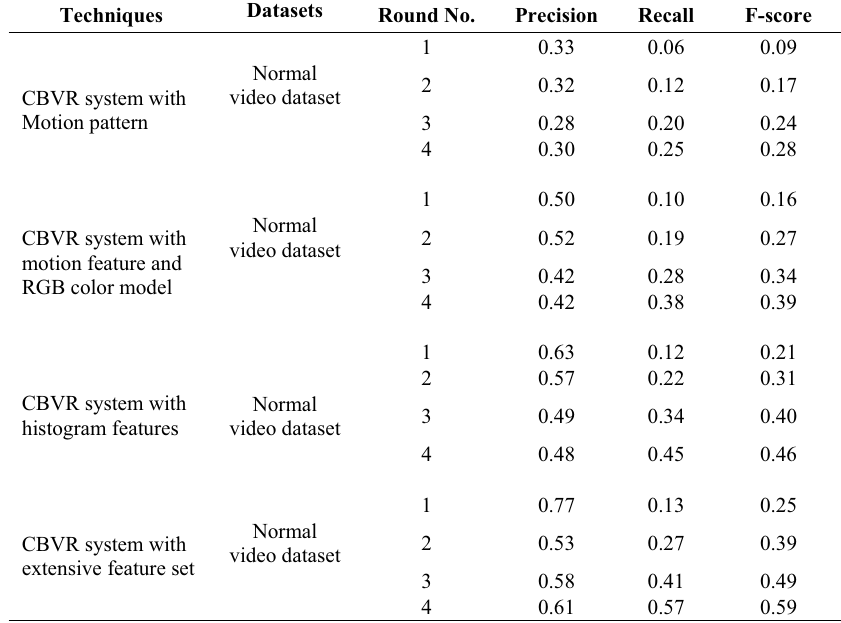
Table. 4. Mean precision, recall and F-score values for different rounds of retrieval obtained by the proposed CBVR system and other existing systems for normal video.